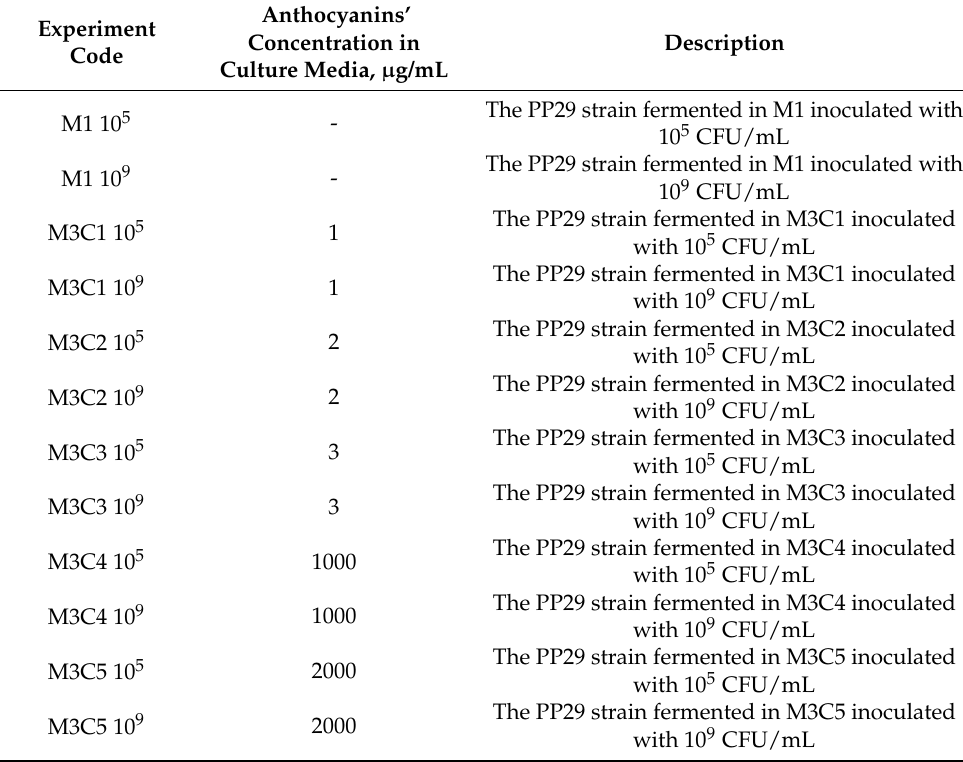
Table 1. The codification and description of the